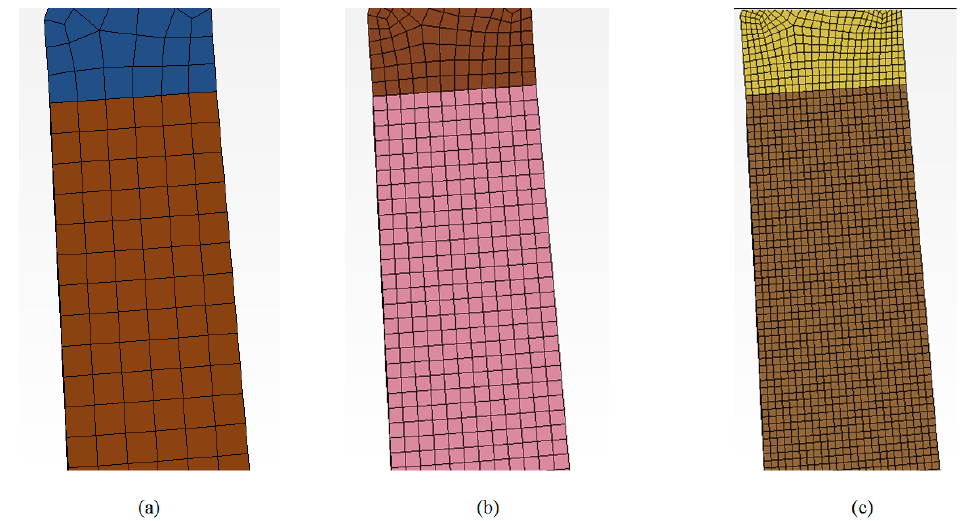
Figure 7. Detailed meshing view of the rear leg of seat models with ( a ) 692 elements, ( b ) 2768 elements and ( c ) 11,052 elements.